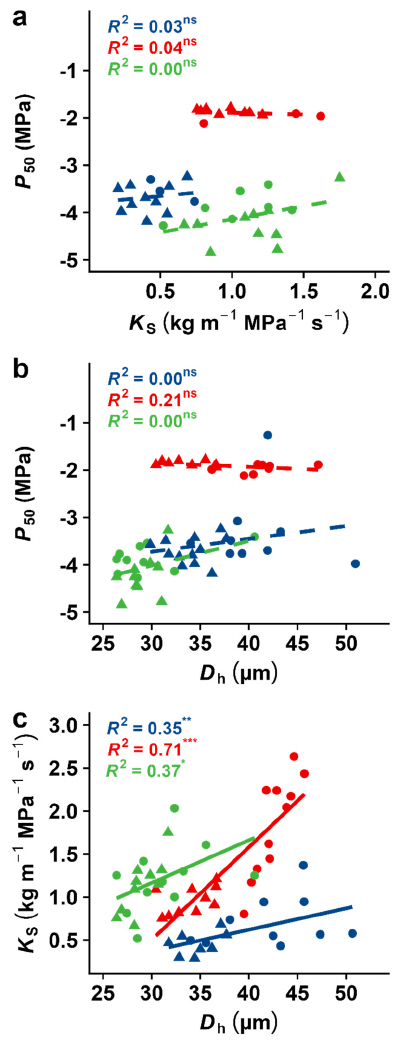
Figure 6. Water potential at 50% loss of hydraulic conductivity ( P 50 ) in relation to ( a ) specific conduc- tivity ( K S ) and ( b ) hydraulically-weighted vessel diameter ( D h ), as well as ( c ) specific conductivity ( K S ) in relation to hydraulically-weighted vessel diameter ( D h ). The results from the linear regression analyses are given. Different colours and symbols represent different species and treatments (blue: A. pseudoplatanus ; red: B. pendula ; green: S. aucuparia ; filled circles: control treatment; triangles: stress treatment). Indicated for each species are the coefficients of determination, i.e., R-squared, for the investigated relationships. Full lines indicate significant effects of variable x on variable y; dashed lines indicate a non-significant relationship. Asterisks indicate the level of significance ( *, p < 0.05; **, p < 0.01; ***, p < 0.001; ns, for